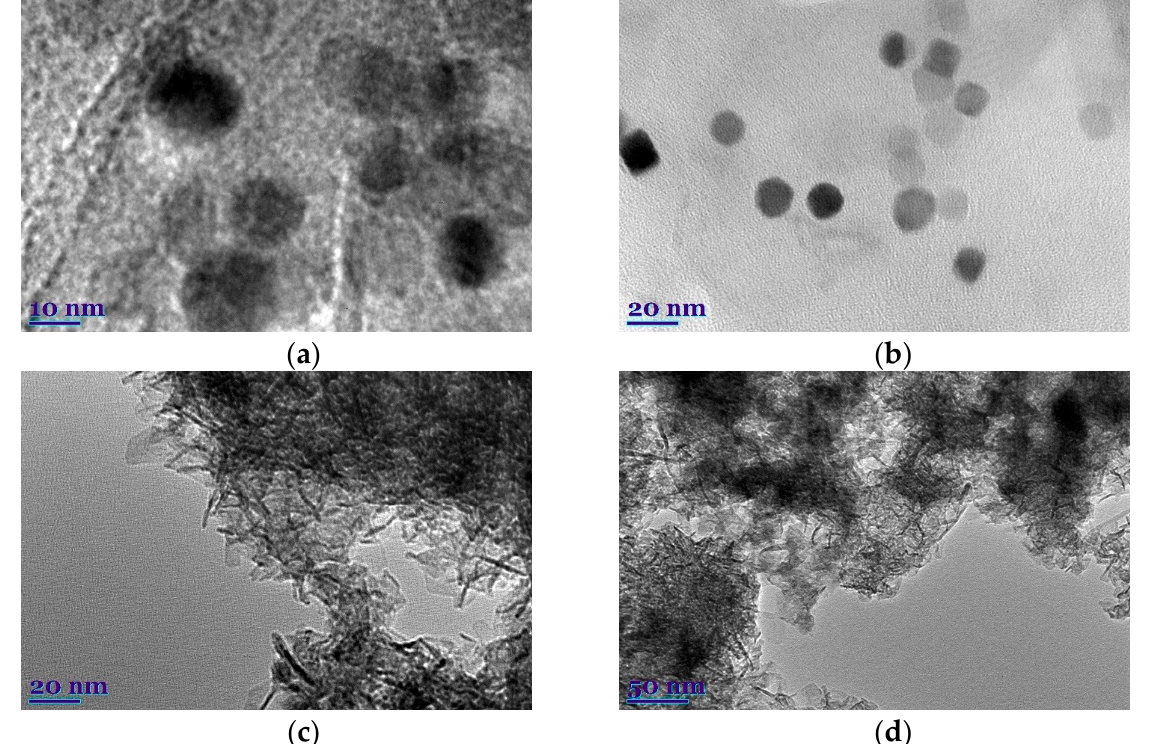
Figure 2. TEM images of MnO 2 /C: ( a , b ) sample S1; ( c , d ) sample S2 under different magnifications.